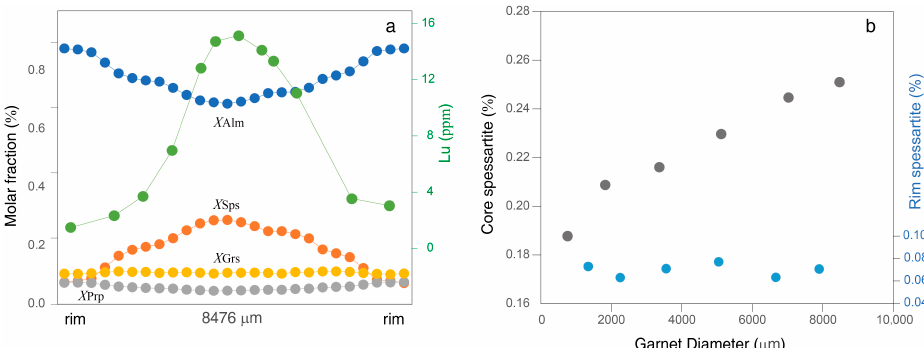
Figure 2. ( a ) Chemical zoning profiles of a representative garnet grain. ( b ) Garnet diameter plotted as a function of the core and rim Mn concentration, showing a correlation between the diameter and the core Mn compositions and similar rim Mn contents for different sized garnets. Table 1. Rim-to-rim traverse electron analyses of a representative garnet 1